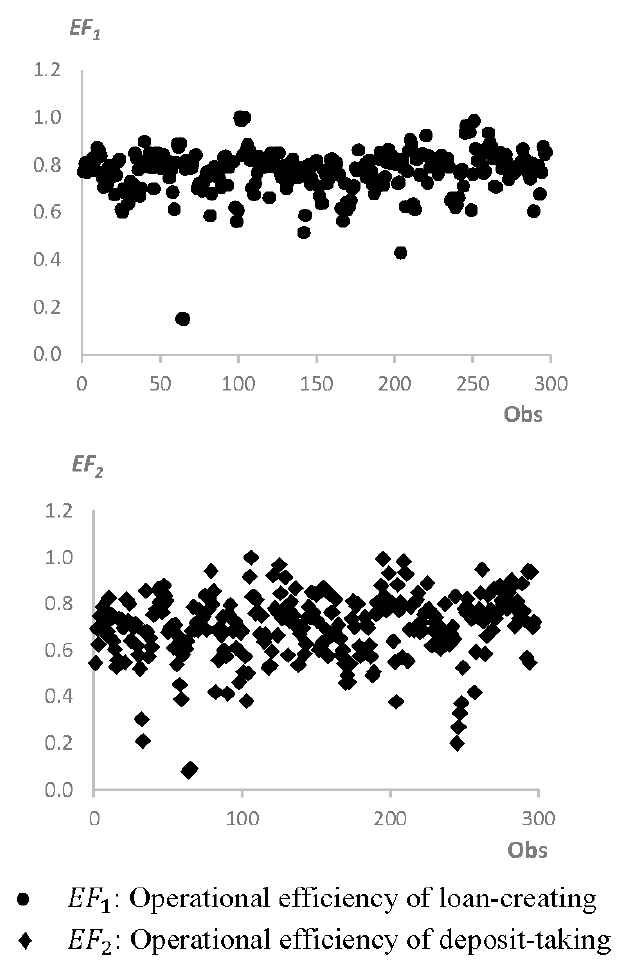
Figure 4. Results of SEM: overview.